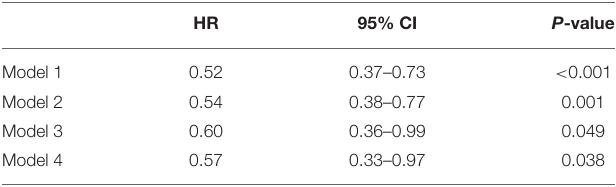
CI, confidence interval. Model 1: adjusted for age and sex. Model 2: adjusted for age, sex,andrespiratorysupport.Model3:adjustedforage,sex,systolicbloodpressure,ADL Hierarchy Scale, Ln (D-dimer), Ln (serum ferritin), and Ln (high-sensitive cardiac troponin T). Model 4: adjusted for age, sex, cognitive impairment, albumin, estimated glomerular filtration rate, Ln (C-reactive protein), and Ln